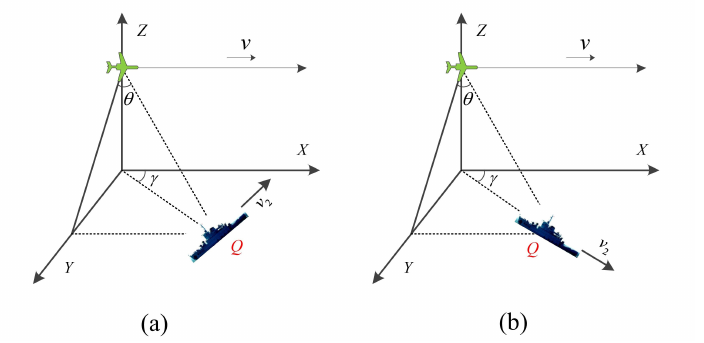
Figure 7. Analysis of ship motion characteristics. ( a ) Only self sway; ( b ) only radial motion